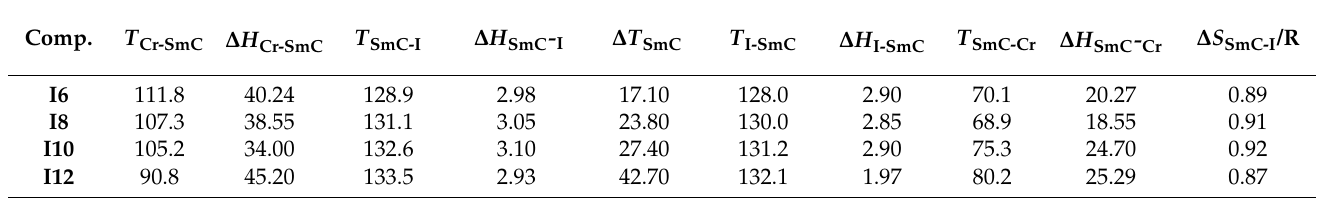
Table 1. Phase transition temperatures upon heating and cooling rounds ( ◦ C), (enthalpy of transition ∆ H , kJ/mole), mesomorphic range ( ∆ T ), and normalized entropy of transition, ∆ S/R for series In .